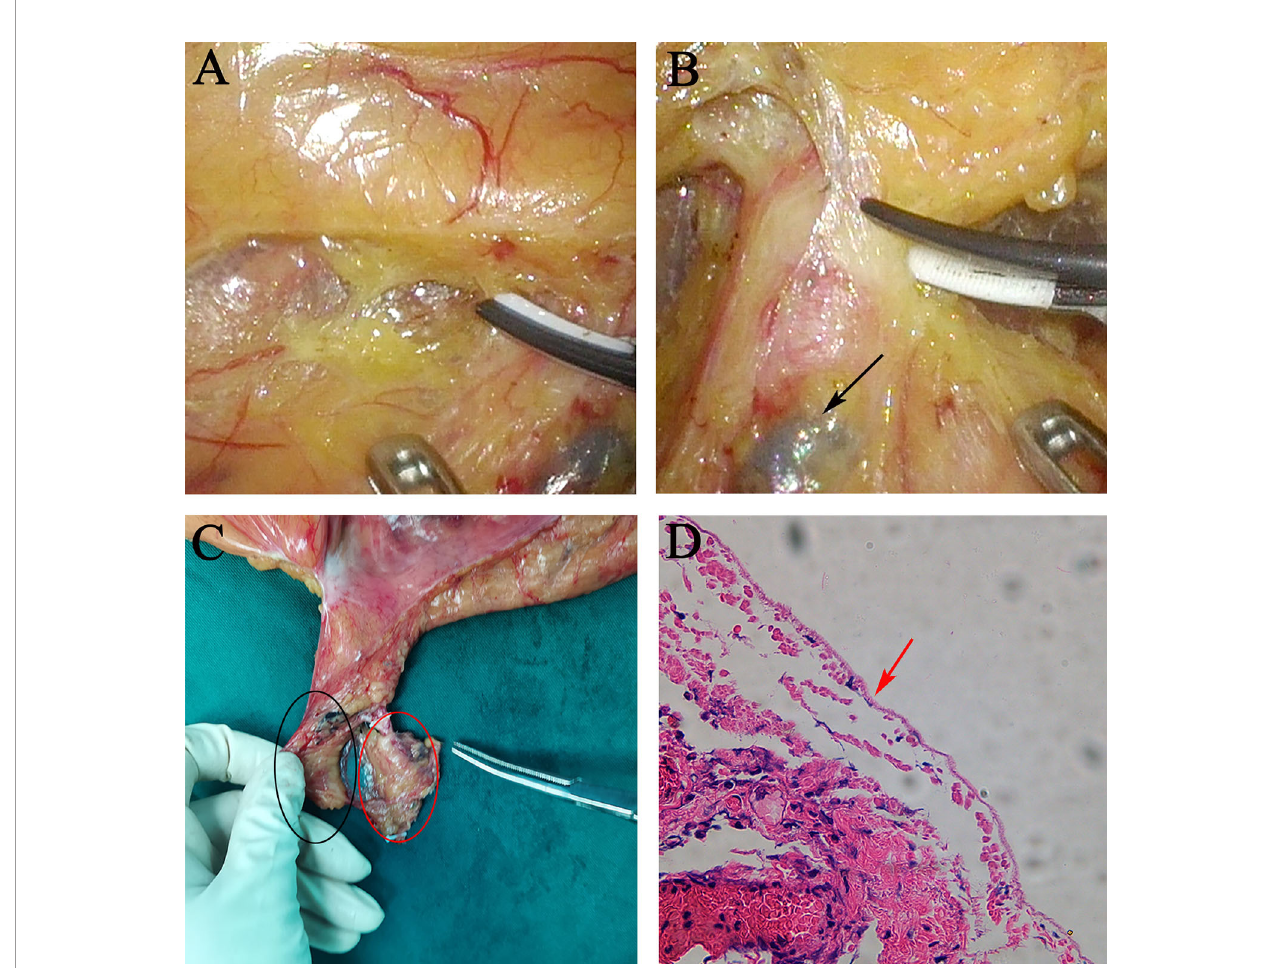
FIGURE 2 | Relationship between extra- and intra-nerve plane station 253 nodes. (A) Inferior mesenteric plexus nerve plane. The IMP was surrounded by the adipose tissue and extremely tiny capillaries and covered by a tiny membranous tissue. (B) Extra-nerve plane station 253 nodes were black-dyed by carbon nanoparticles. (C) Postoperative gross specimen of en bloc station 253 nodes. Black and red ovals show intra- and extra-nerve plane station 253 nodes, respectively. (D) H&E staining showing completely excised mesorectum of intra-nerve plane station 253 nodes; no nerve bundles were found in intra-nerve plane station 253 nodes. IMA, inferior mesenteric artery; IMP, inferior mesenteric